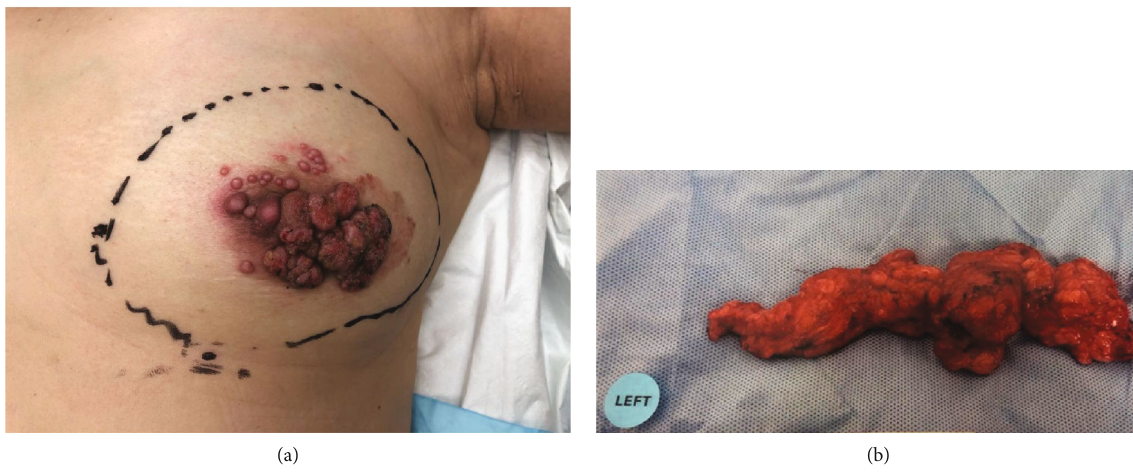
Figure 1: (a) Clinical appearance of the breast lesion. (b) Clinical appearance of the axillary dissection